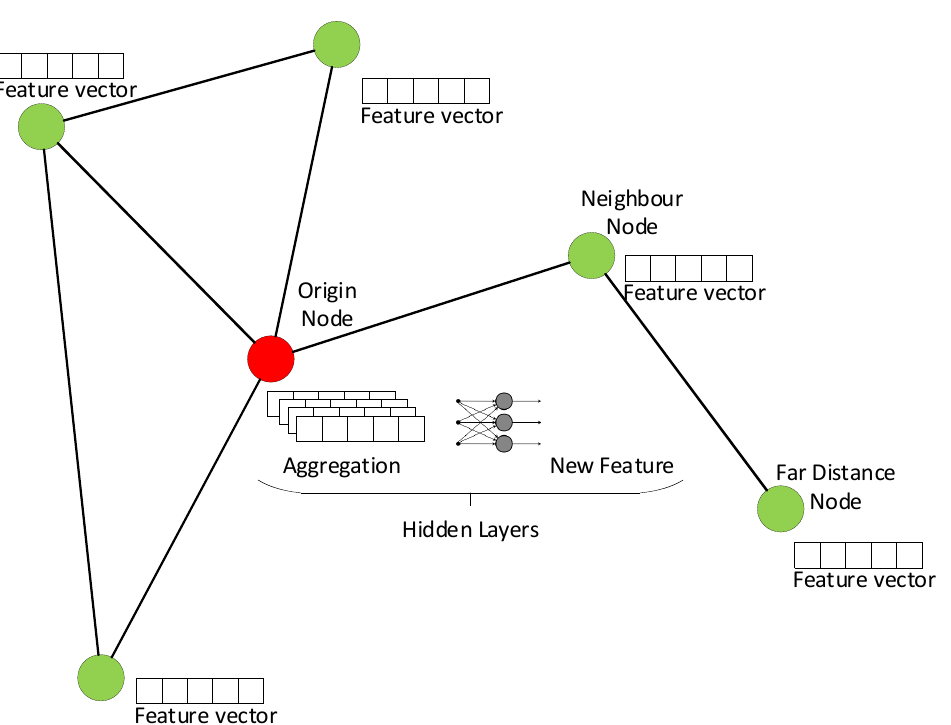
Figure 1. Graph convolutional network.